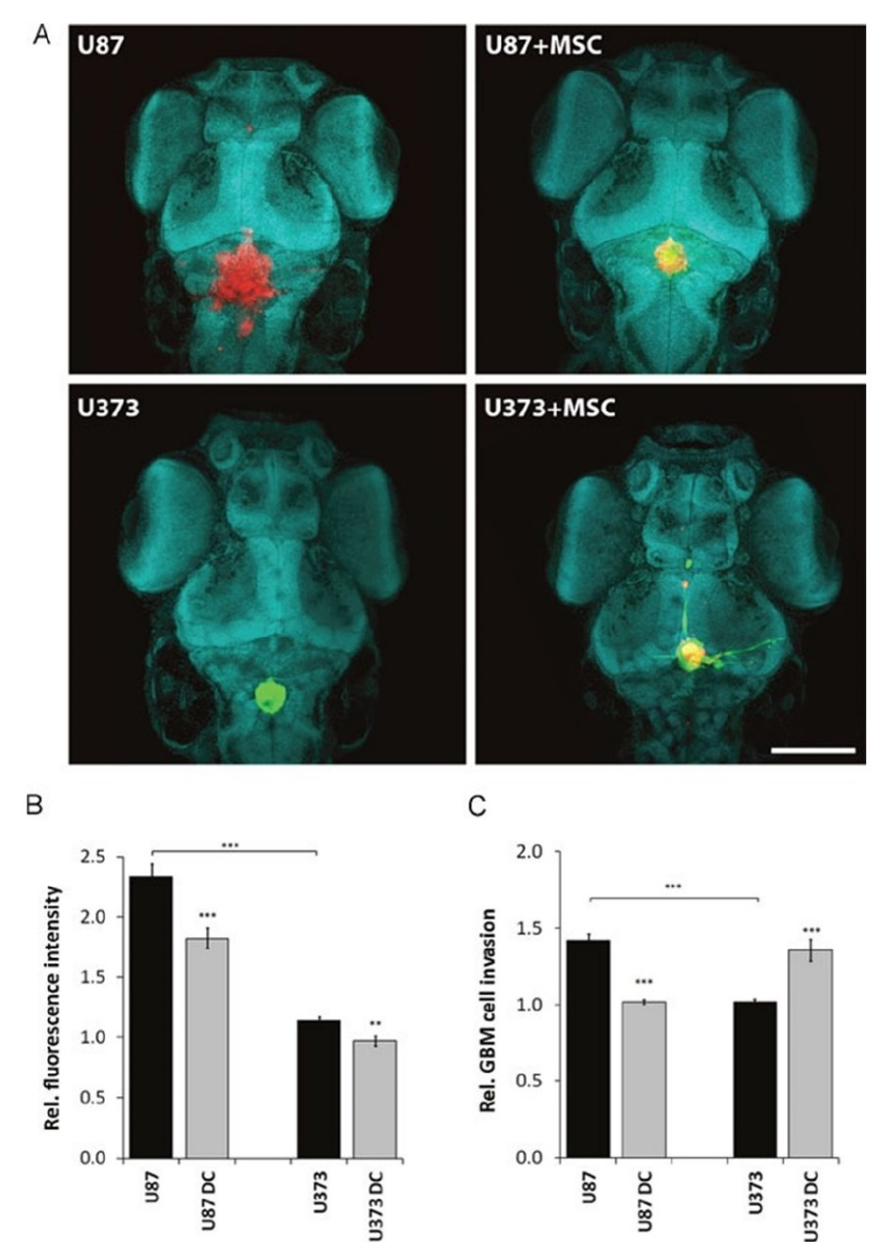
Figure 2. Proliferation and invasion of U87 dsRED and U373 eGFP cells in the zebrafish embryo brain upon co-injection with DiO/DiI-labelled MSCs. ( A ) Two days after zebrafish embryo fertilization, U87 and U373 cells alone (left upper and lower panels) or mixed with fluorescently stained MSCs with DiO (green) in the case of U87 (right upper panel), and with DiI (red) in the case of U373 (right lower panel), were injected into the brains of the zebrafish embryos. Cell nuclei were stained with methyl green (magnification, 10 × , green blue shapes; scale bar = 250 µ m). ( B ) GBM cell proliferation was determined 24 and 72 h after the injections by confocal microscopy and quantified as relative fluorescence intensity of U373eGFP and U87dsRed labelled cells injected alone or with MSCs (DC). ( C ) Relative invasion of U87dsRed and U373eGFP cells injected alone, or with fluorescently stained MSCs (DC) was determined as described in Material and Methods, clearly showing increased U373eGFP invasiveness and reduced U87 invasiveness from co-culture xenografts. Thirty zebrafish embryos were used per group. Data are means ± SD. ** p < 0.01, *** p < 0.001 [121]. (CC BY